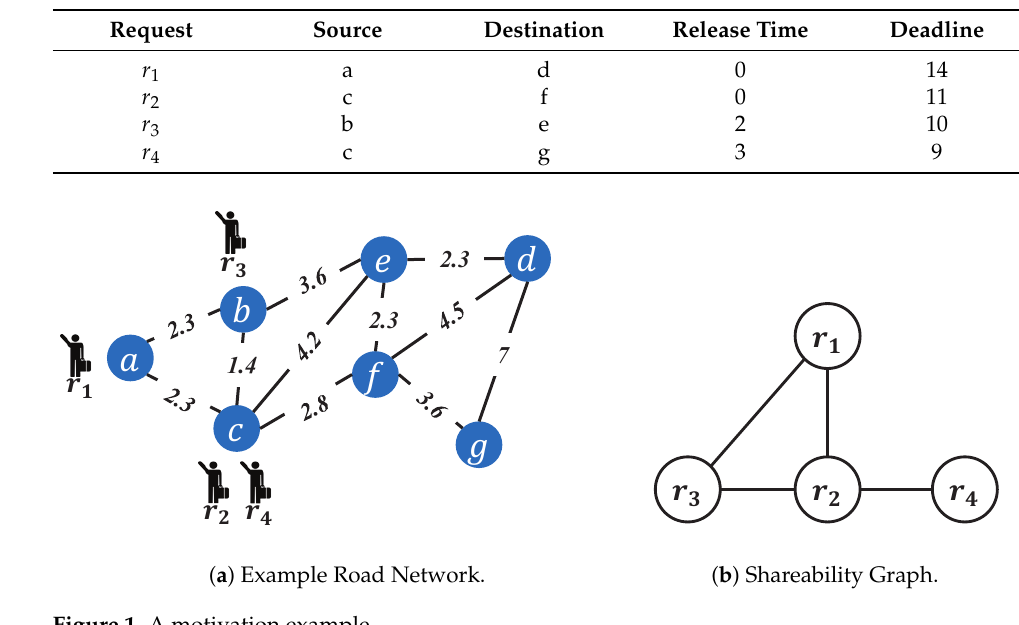
Table 1. Requests release detail.